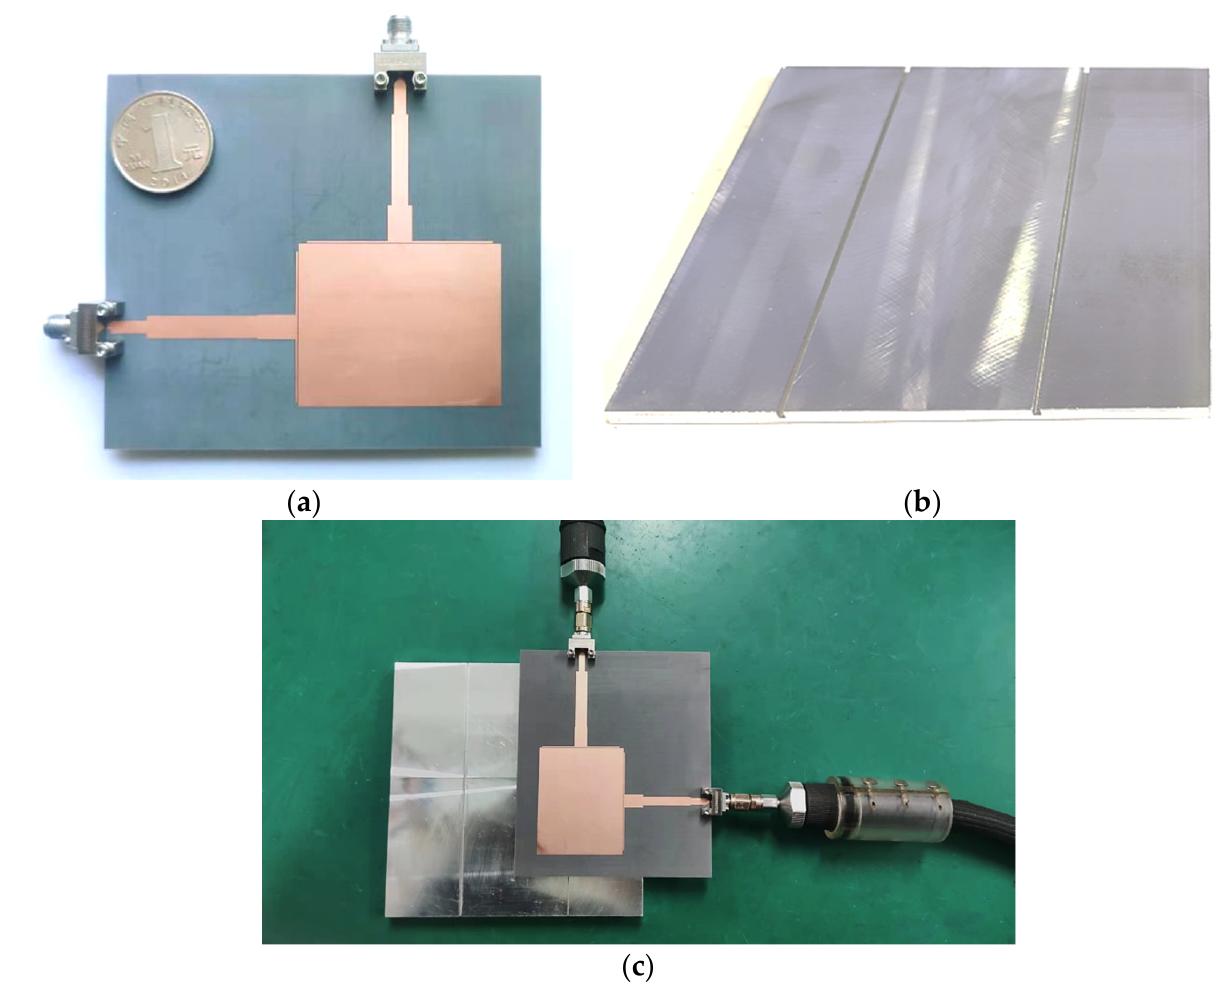
Figure 13. Fabrication and measurement. ( a ) Fabricated sensor. ( b ) Metal crack on aluminum plate. ( c ) Reflection coefficient measurement by VNA.